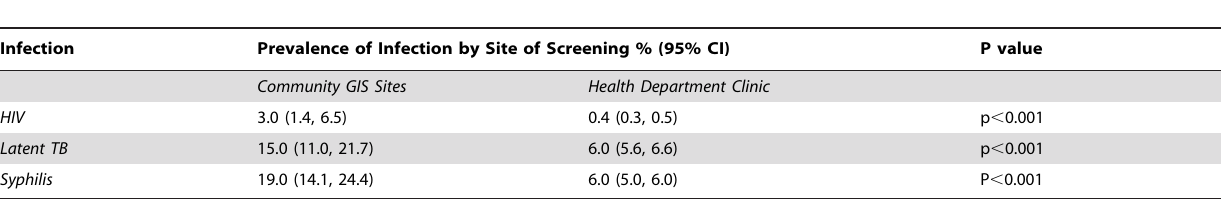
Table 3. Measured Prevalence of HIV, Latent Tuberculosis, and Syphilis in Study Group Compared to Health Department Clinic